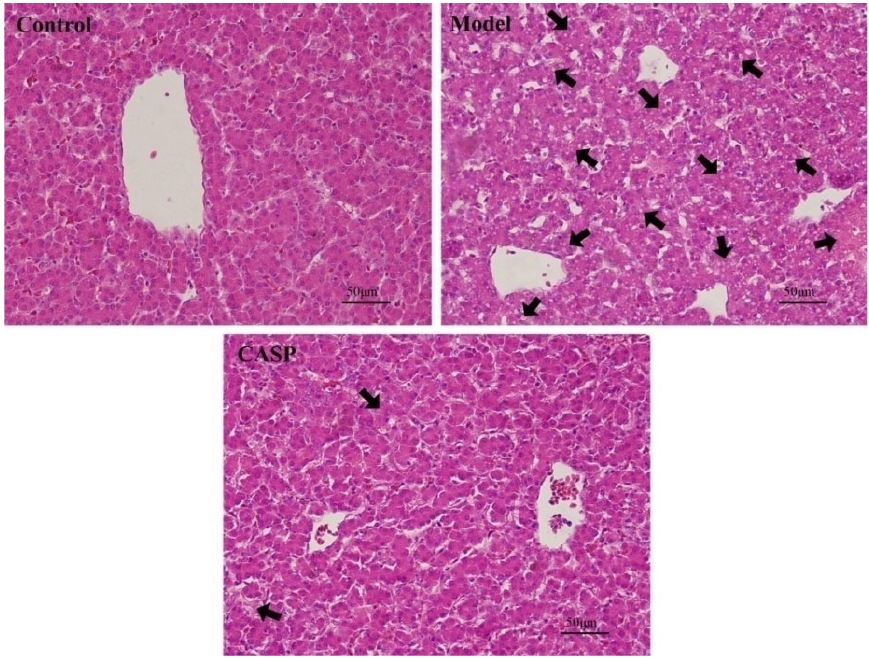
Figure 1. Pathological observation results of chicken liver of each group (HE, 400×). Note: The black arrows refer to the obvious hepatic lesions.